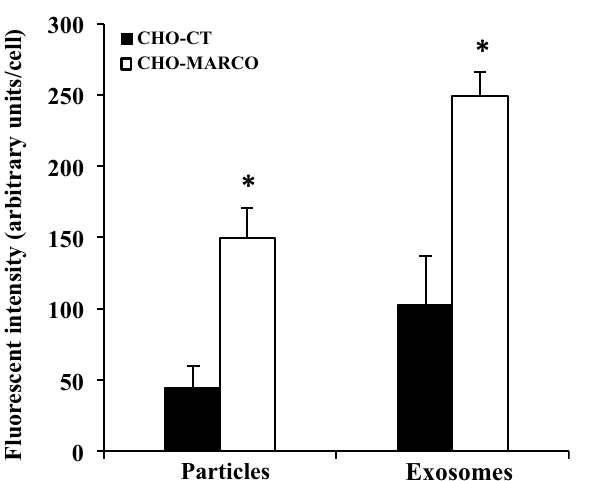
Figure 2. Effects of MARCO on interaction with exosomes ( A ) or 20-nm nanoparticles ( B ). T-REx-CHO- MARCO cells were cultured in a multi-well glass-bottom dish with (CHO-MARCO) or without (CHO-CT) tetracycline. After 24 h of culture, the cells were exposed to green fluorescent exosomes ( A ) or 20-nm red fluorescent nanoparticles ( B ) for 6 h. Cellular association was observed using fluorescence microscopy.